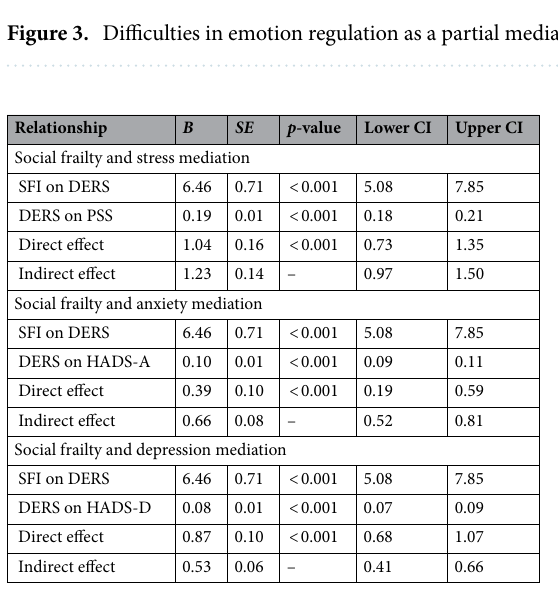
Table 3. Unstandardised regression coefficients, standard error and 95% confidence intervals for each mediation model. The indirect effect for each mediation used Bootstrapping. CI confidence interval, SFI Social Frailty Index, DERS Difficulties in Emotion Regulation Scale, PSS Perceived Stress Scale, HADS-A/D Hospital Anxiety and Depression Scale-Anxiety/Depression